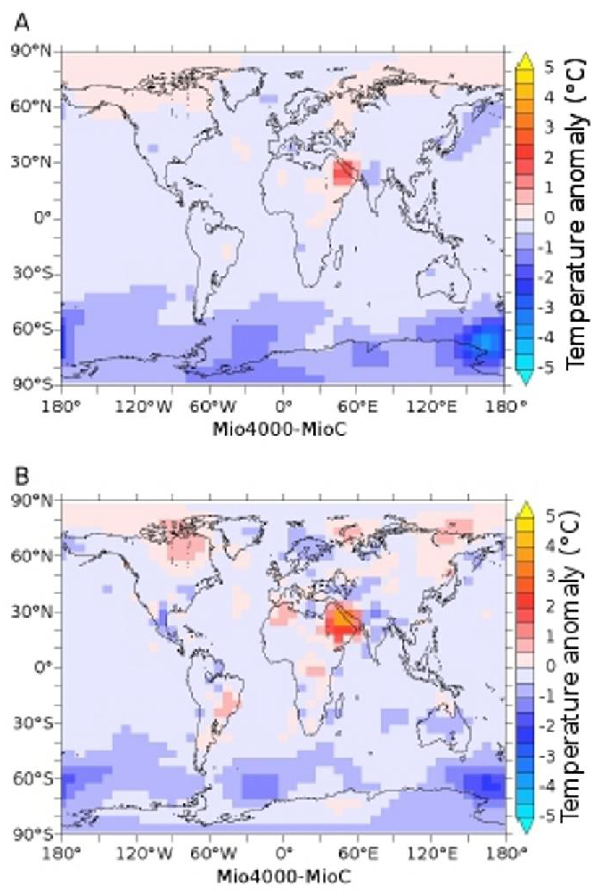
Fig. 12. Annual mean surface air temperature anomaly ( ◦ C): MioC–